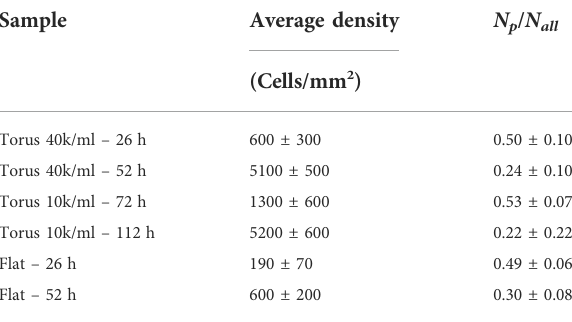
TABLE 1 Average cell density and proliferation